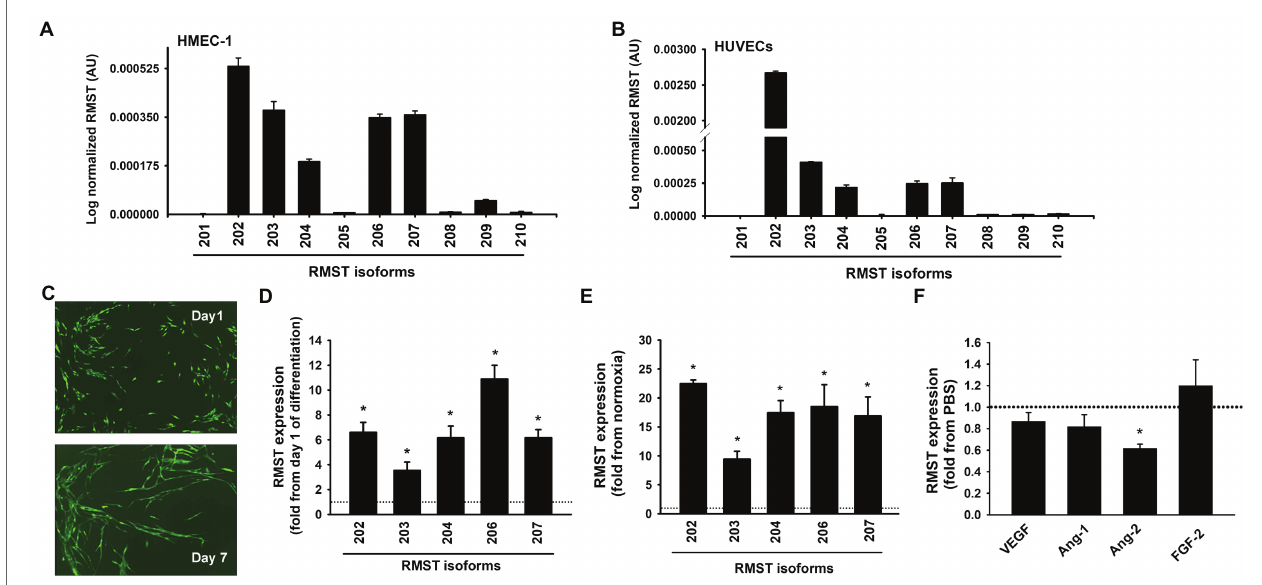
FIGURE 1 | RMST expression in human ECs. (A,B) Log normalized mRNA expressions of various RMST isoforms in human umbilical vein endothelial cells (HUVECs; A ) and human microvascular endothelial cells (HMECs; B ). Values are means ± SEM, expressed as arbitrary units. N = 6 per isoform. (C) Representative angiogenesis assay images in which GFP-HUVECs were co-cultured with human lung fibroblasts for 1 (top) and 7 (bottom) days. Note differentiation of cells into tube-like structures. (D) mRNA expressions of 5 RMST isoforms in GFP-HUVECs after 7 days of co-culture with human lung fibroblasts. Values are means ± SEM, expressed as fold from day 1 of co-culture values. * p < 0.05, compared to day 1. N = 5. (E) mRNA expressions of 5 RMST isoforms in HUVECs in response to 24 h of hypoxia (5% CO 2 and 95% N 2 ). Values are means ± SEM, expressed as fold from normoxic values. * p < 0.05, compared to normoxia. N = 8. (F) mRNA expressions of RMST-202 in HUVECs maintained in basic medium then exposed to PBS (control), VEGF (40 ng/ml), Ang-1 (300 ng/ml), Ang-2 (300 ng/ml), and FGF-2 (10 ng/ml) for 24 h. Values are means ± SEM, expressed as fold from PBS. * p < 0.05, compared to PBS. N =